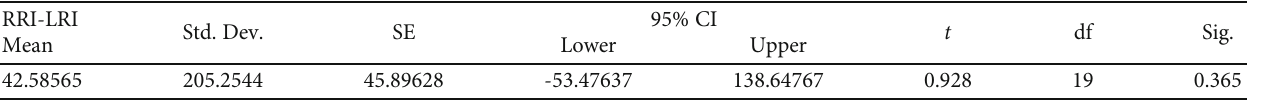
Table 1: Paired sample t